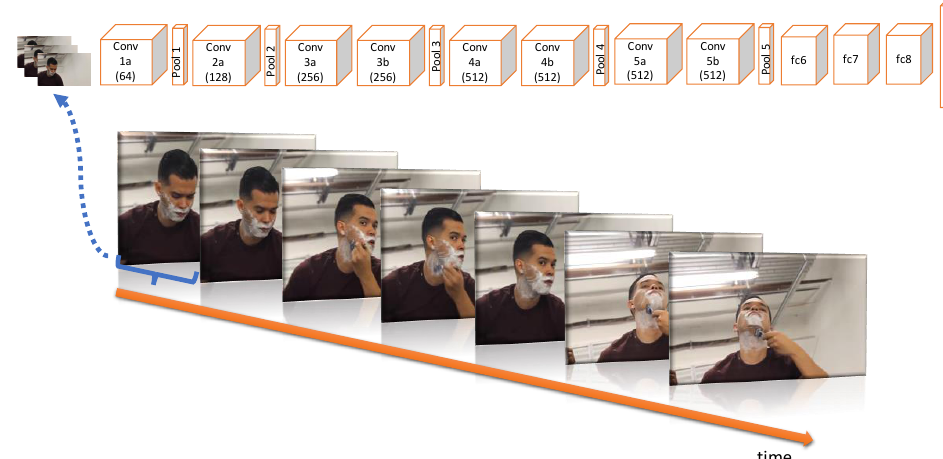
Figure 3. This figure shows the deep learning model OAD-3D-CNN, which is used for the monitoring of the daily-life activities of the users. Our model has 8 3D convolutions, 5 max-pooling layers and 3 fully connected layers, followed by a softmax output layer. All 3D convolution kernels are 3 × 3 × 3 with stride = 1 in both spatial and temporal dimensions. Note that in each box we indicate the number of filters. The 3D pooling layers are denoted pool1 to pool5, where the pooling kernels are 2 × 2 × 2, except pool1, for which it is 1 × 2 × 2. The fully connected layers have 4096 output units. Note that we apply 3D convolutional blocks directly to the input video volume